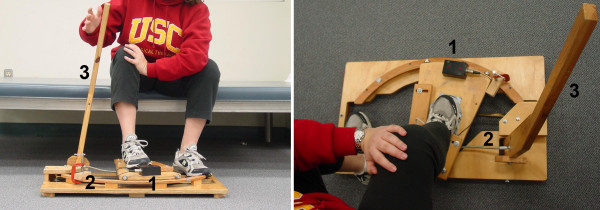
Exercise unit for isolated tibialis posterior exercise. (1) LED displaying static plantar flexion from pressure sensors under forefoot; (2) Constant force extension spring for dynamic adduction; (3) Lever to allow passive adduction or abduction of the foot.